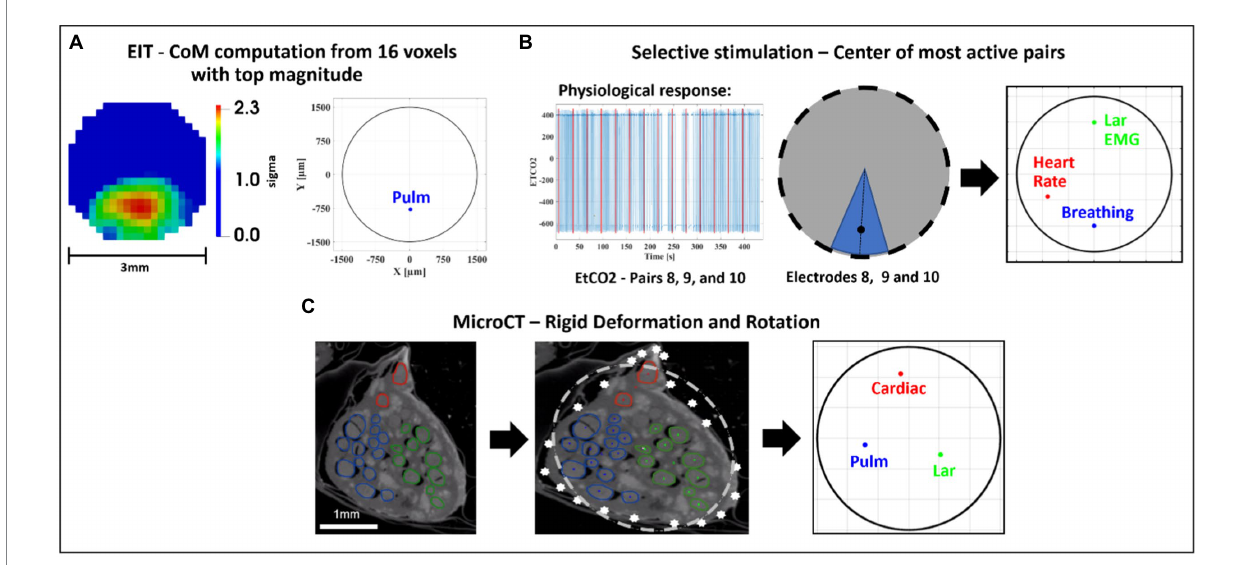
FIGURE 5 Image co-registration. (A) The 16 voxels (5% of mesh elements) with top magnitude from the reconstructed EIT image are selected to compute center of mass (CoM) of functional activation. The color scale is arbitrary units (Z score of relative change in the modulus of the impedance). (B) Example of electrode pair(s) inducing most localized and highest-intensity physiological response (EtCO2, blue) during selective stimulation (red bars); most selective pairs were chosen to compute angular component of the CoM for this technique; radial component is chosen as 2/3rds of nerve radius. (C) CoM for each branch [cardiac, pulmonary (Pulm)], and recurrent laryngeal (Lar) is computed from segmented microCT images which are then subject to rigid deformation and rotation for co-registration with the other methods.